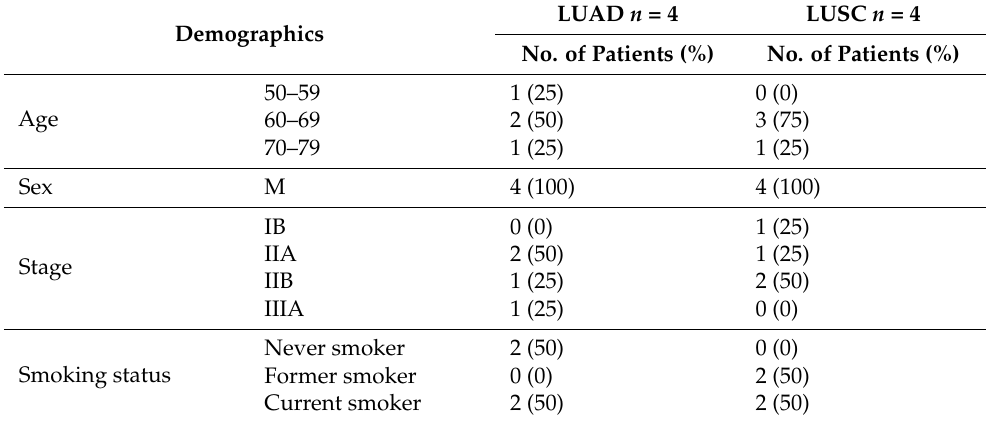
Table 2. Sample characteristics of the 8 male NSCLC patients used for miRNA microarray